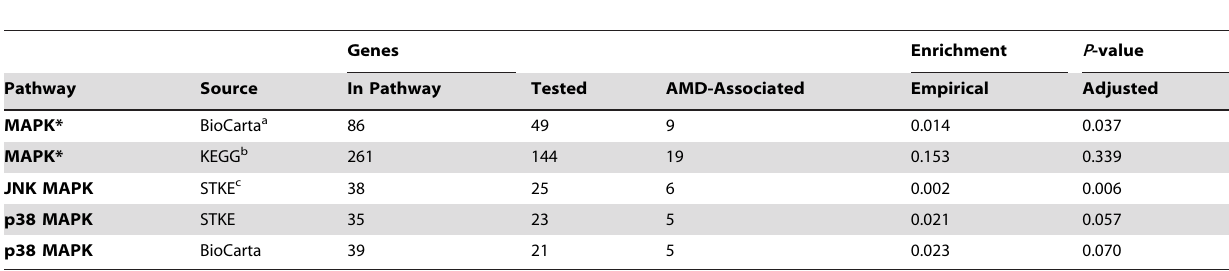
Table 1. Five published MAPK pathways examined for enrichment with AAMD-associated genomic